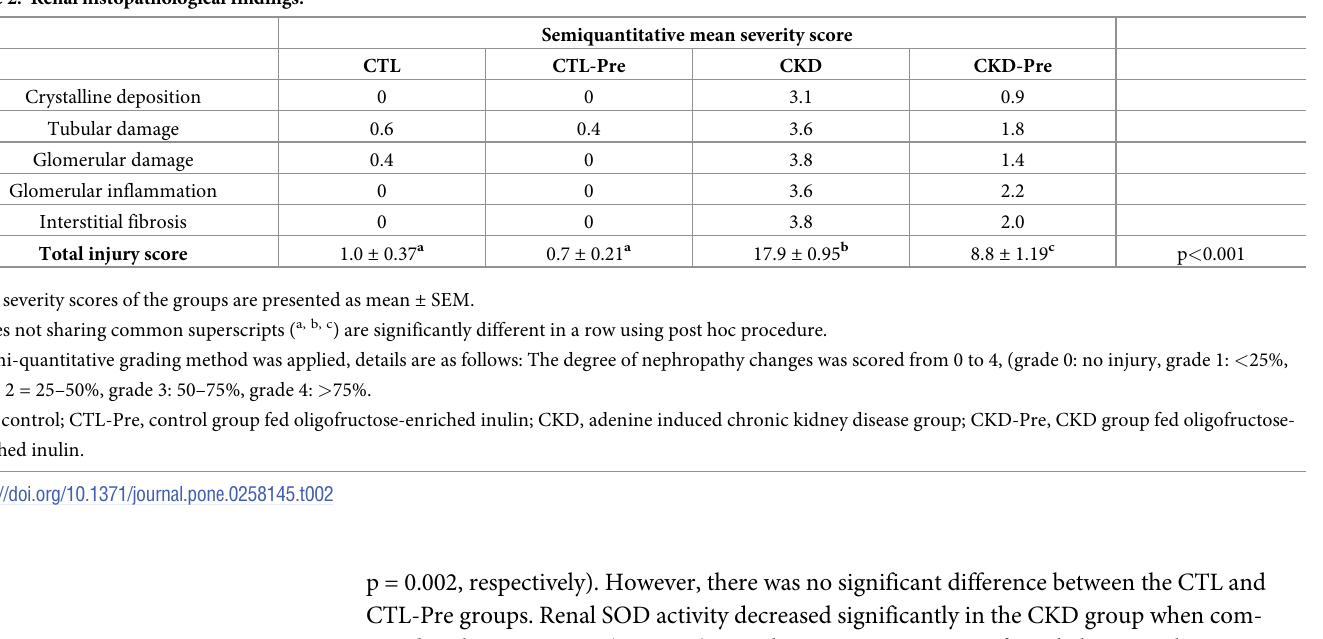
Table 2. Renal histopathological findings.